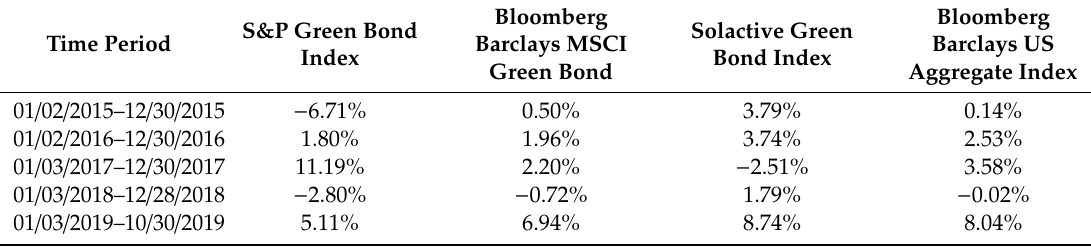
Table 4. Performance of bond